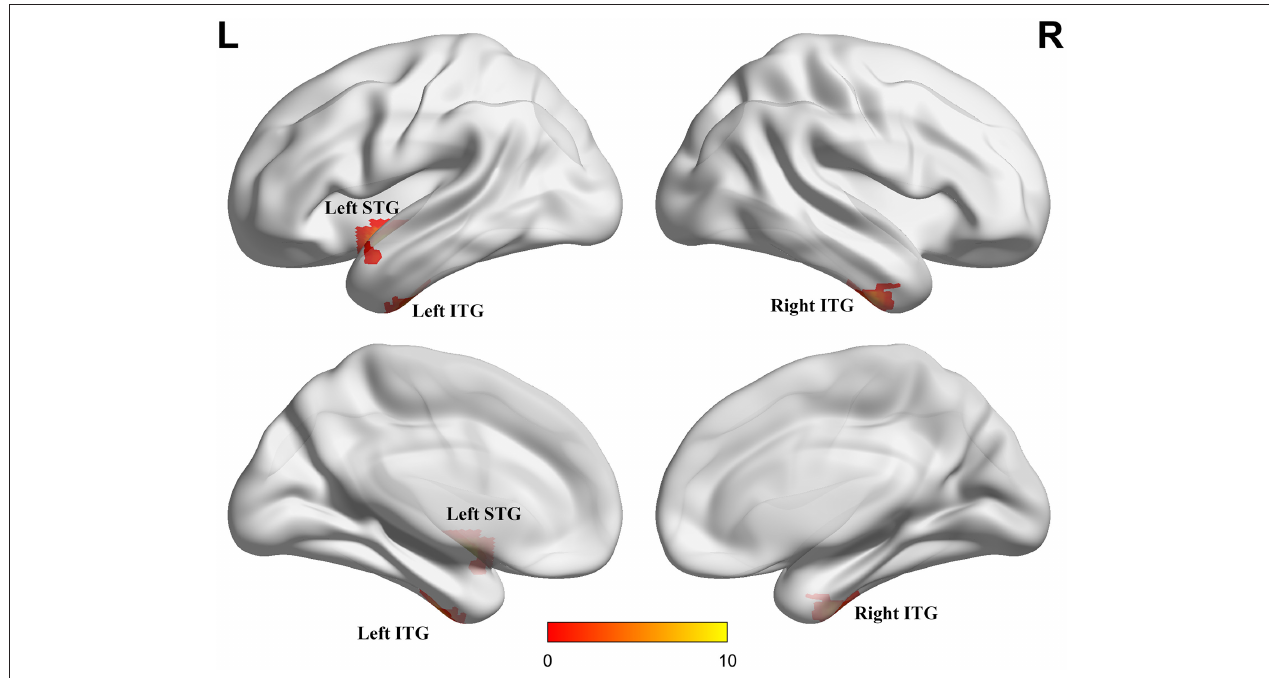
FIGURE 2 | Three brain regions with significant differences in fALFF. These regions are the left superior temporal gyrus (left STG), the left inferior temporal gyrus (left ITG) and the right inferior temporal gyrus (right ITG), respectively. The results were obtained by analysis of covariance (ANCOVA) analysis adjusted with mean age, gender, education and mean frame-wise displacement [FD; P < 0.005, cluster level < 0.05, two-tailed, Gaussian random field (GRF) correction].